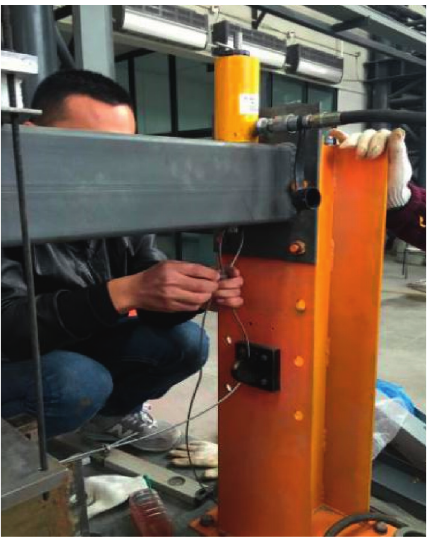
Figure 7: Horizontal loading